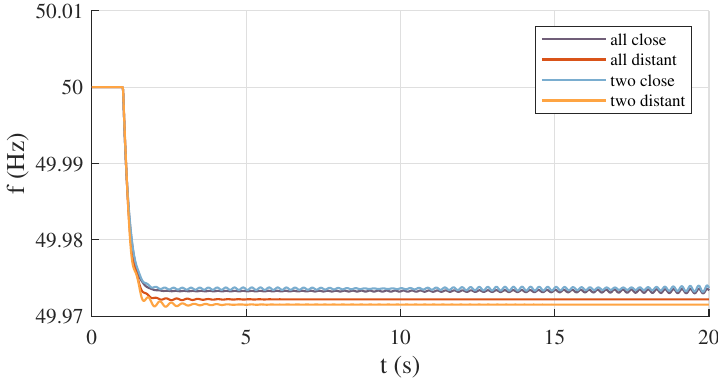
Figure 10. Impact of location of grid-forming